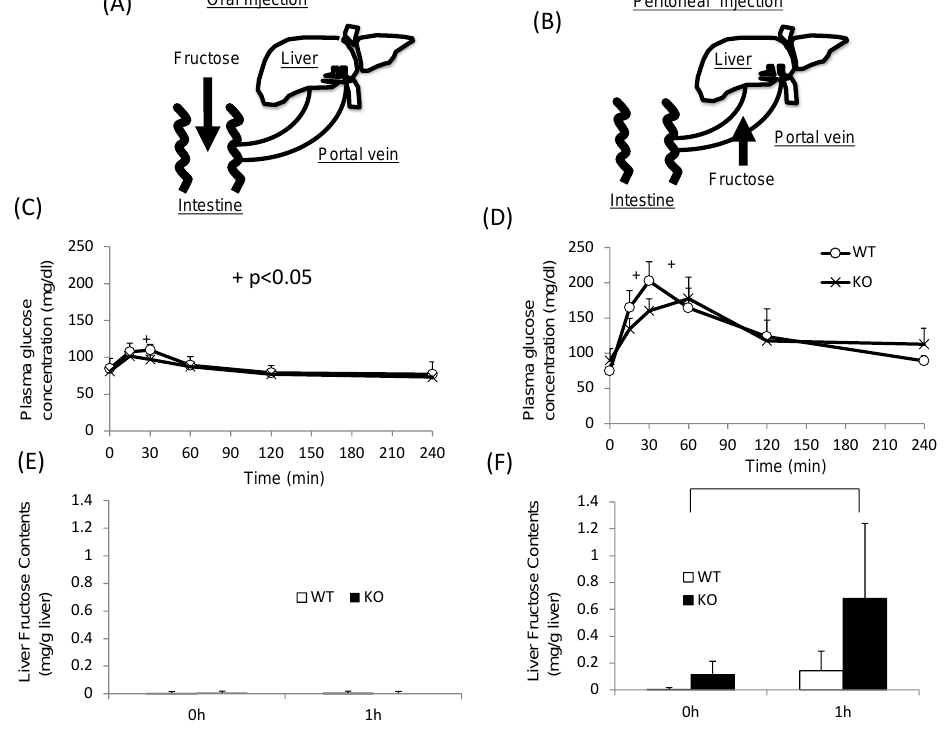
Figure 4. Oral and peritoneal fructose injection test. Oral ( A ) and perinoteal ( B ) injected fructose is abosorbed in intestine and portal vein, respectively. Time course of glucose concentration after oral ( C ) or peritoneal ( D ) fructose injection. Liver fructose content at 0 and 1 h after oral ( E ) or peritoneal ( F ) fructose injection. Data are presented as means ± SD ( n = 6 per group). + WT vs. KO, p < 0.05.